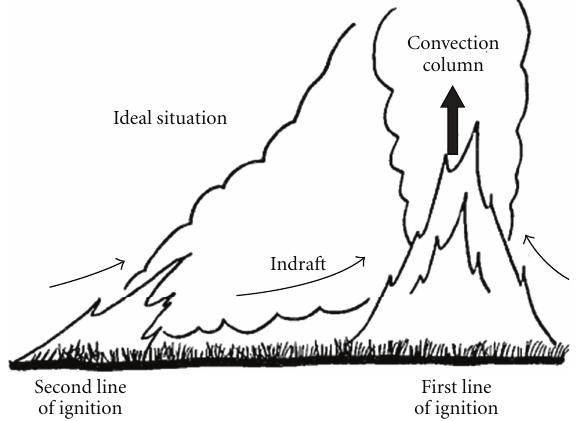
Figure 2: Indrafting and flame response of sequential line fires in prescribed burning